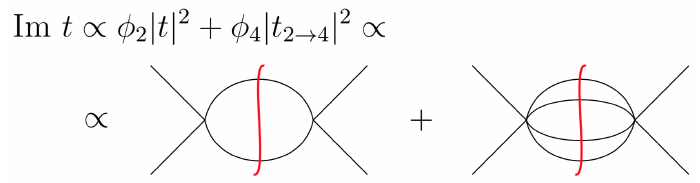
Figure 2: When considering each of the 2- or 4-body phase spaces, we have assigned 2 π factors according to the normalization of one-pion states. For each pion in an intermediate state there is a factor ( 2 π ) − 4 . However, when calculating the imaginary part of the amplitude, each cut line will produce an extra 2 π (together with a f − 1 This leaves the typical ( 2 π ) − 3 normalization factor for each pion. Hence, we must only use f 4 to compare the two-body and four-body phase π